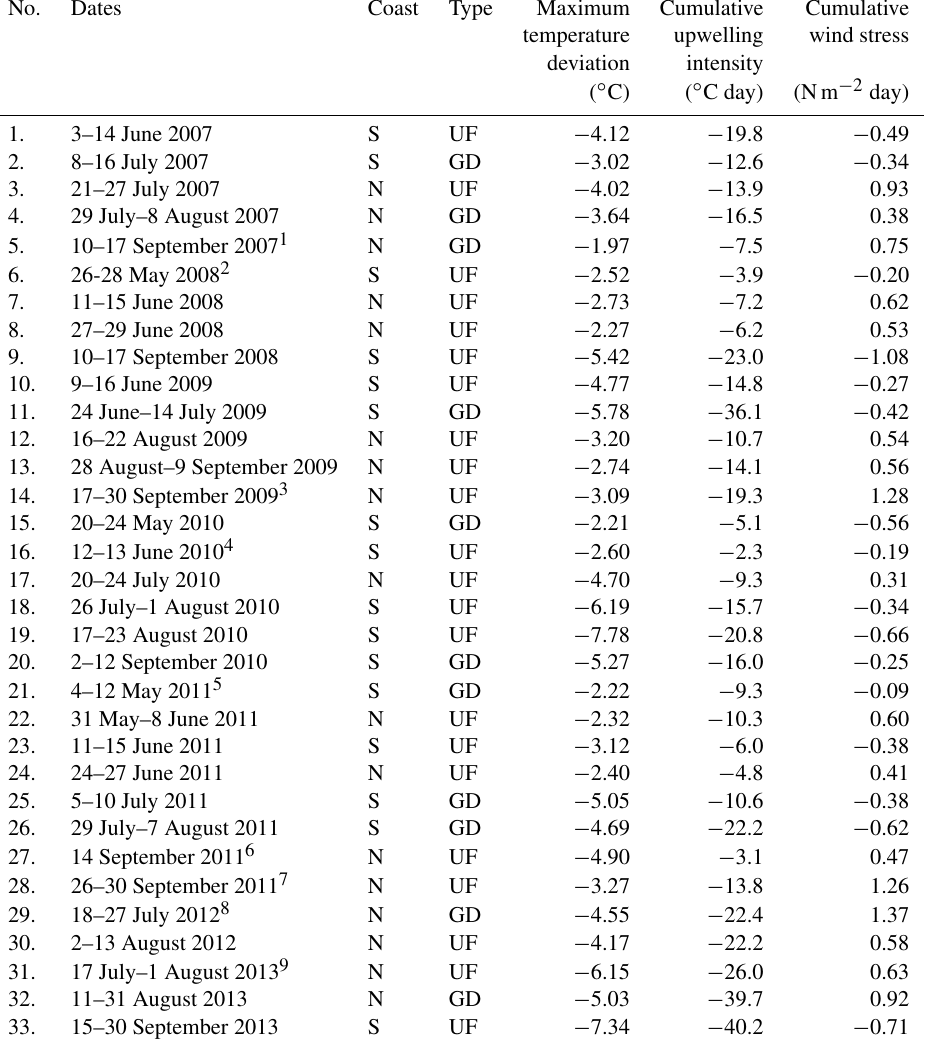
Table 2. Characteristics of detected upwelling events; dates, coastal area (N – off northern coast; S – off southern coast), type (UF – with strong upwelling front; GD – with gradual decrease in temperature), maximum temperature deviation from the transect mean value, cumulative upwelling index calculated for each event and cumulative along-gulf wind stress calculated for upwelling favorable winds before and during the upwelling